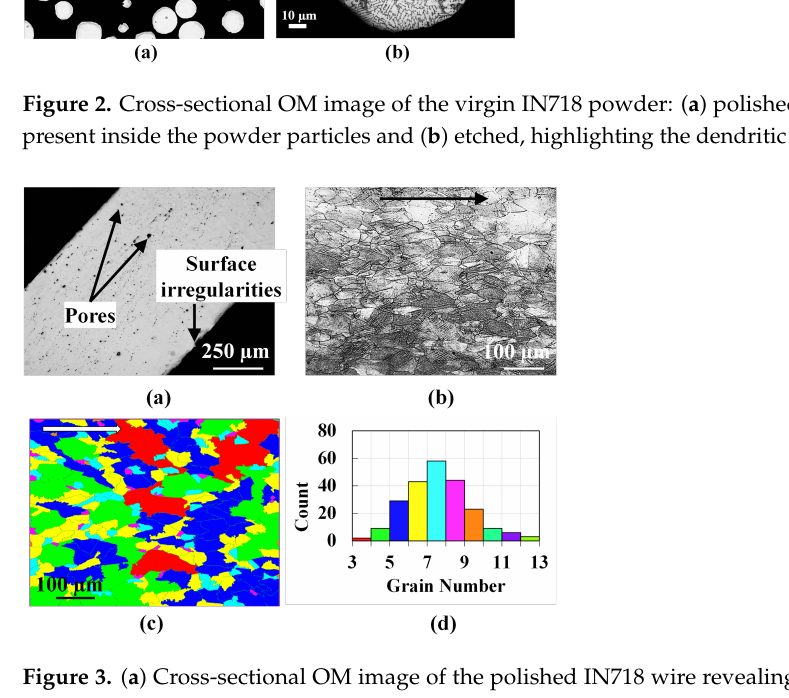
Figure 3. ( a ) Cross-sectional OM image of the polished IN718 wire revealing internal and surface pores. ( b ) Cross-sectional image of the etched IN718 wire depicting the grains. The black arrow in ( b ) indicates the drawing direction. ( c ) A representative etched cross-section analyzed using LAS X Grain Analysis module and color coded according to the grain number. The white arrow in ( c ) indicates the drawing direction. ( d ) The histogram of grain